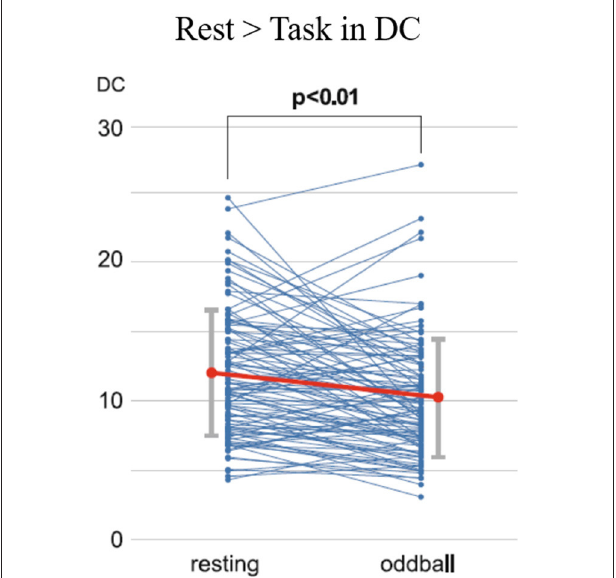
as an intra-network connectivity marker (Degree Centrality.